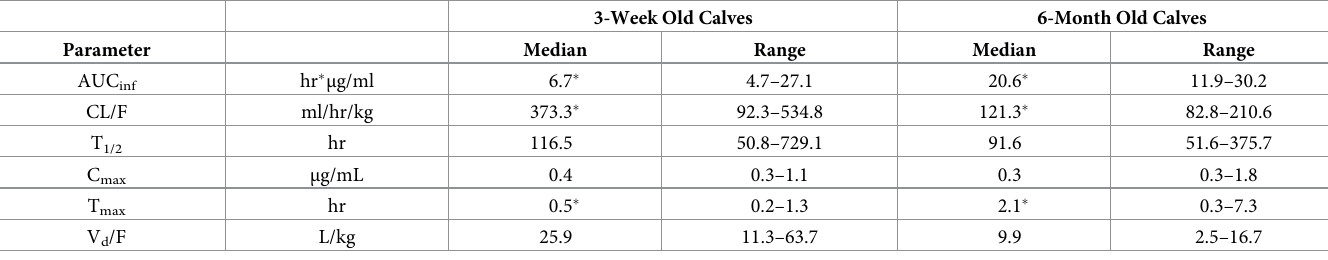
Table 3. Pharmacokinetic parameters for tulathromycin in 3-week old vs. 6-month old calves with respiratory